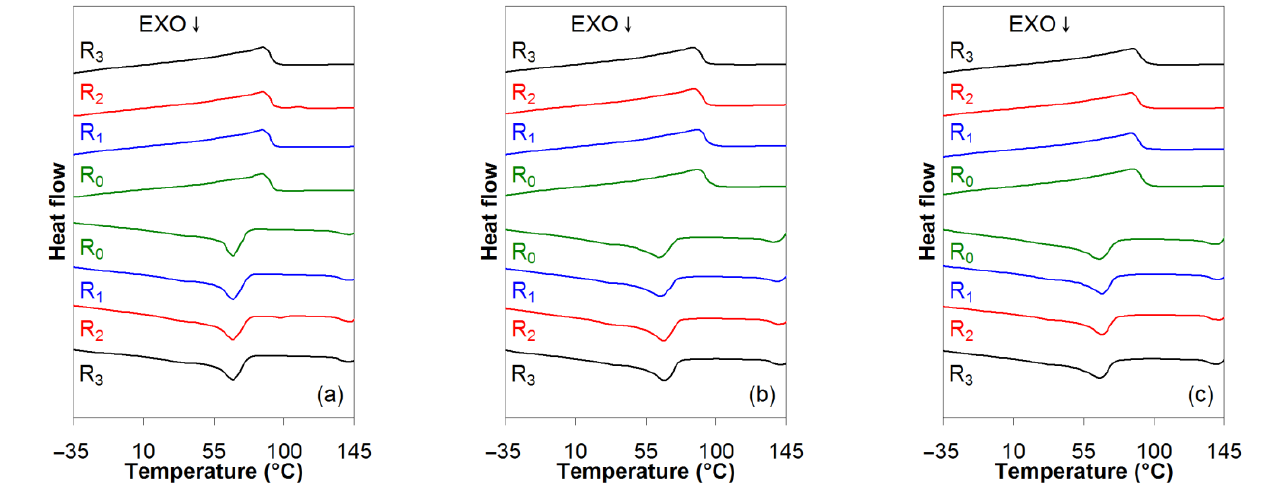
Figure 3. Effect of reprocessing cycle on the first cooling and second heating scans of the EVA/MWCNT nanocomposites with ( a ) 1 wt.%, ( b ) 3 wt.%, and ( c ) 5 wt.% of MWCNTs.